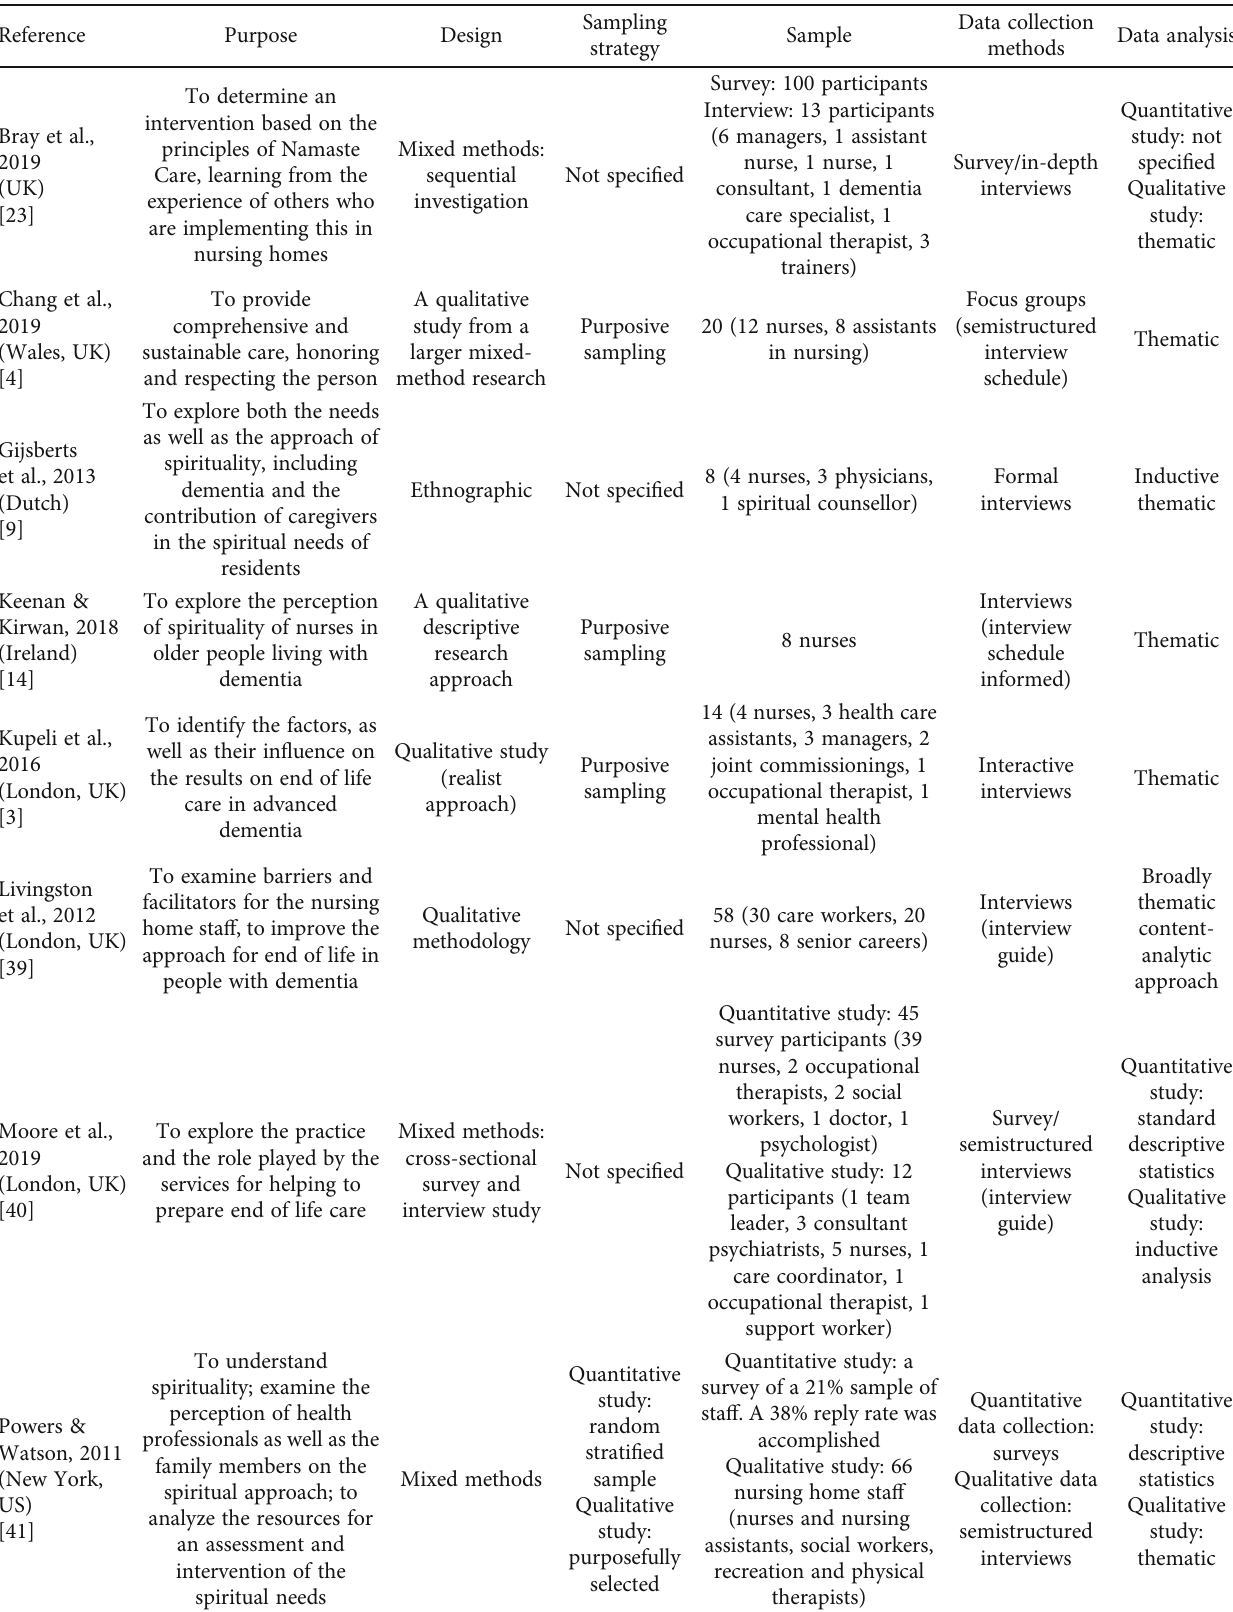
Table 2: Characteristics of studies